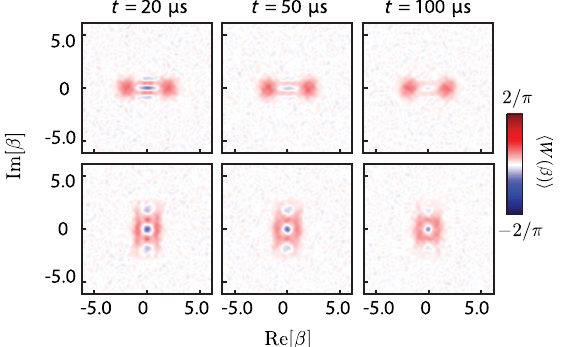
FIG. 8. Discrete Fourier transformation. Wigner function of odd cat with 0 dB (top) and − 7 . 6 dB (bottom) compression at the decay time of 20, 50, and 100 μ s,